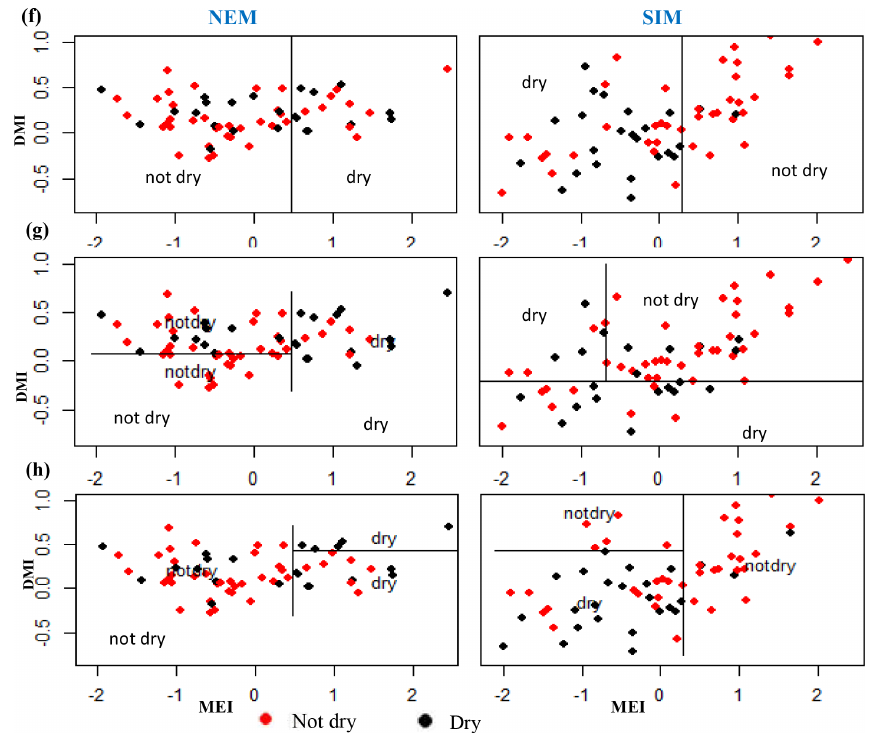
Figure A9. Random forest importance of variables to identify the dry and not dry classes of rainfall